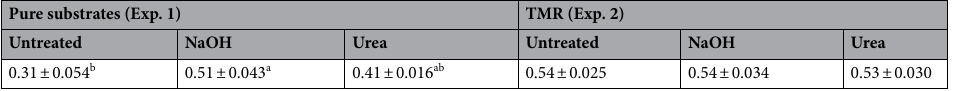
Table 5. In vitro organic matter digestibility coefficients (ruminal digestibility) determined in untreated barley straw, NaOH treated straw, and urea treated straw (Experiment 1), and in TMR including one of these straw treatments (Experiment 2) according to Menke and Steingass 27 (equation no 43f.) on the basis of gas production and crude nutrient analyses. Practical TMR were composed of 33.5% maize silage, 21.6% rapeseed meal, 26.7% barley grains, and 18.2% of one of the straw treatments on DM basis. The straw treatments and conducted experiments are specified in the text. DM, dry matter; TMR, total mixed ration. ab Superscripts indicate differences among the treatments ( p < 0.05).